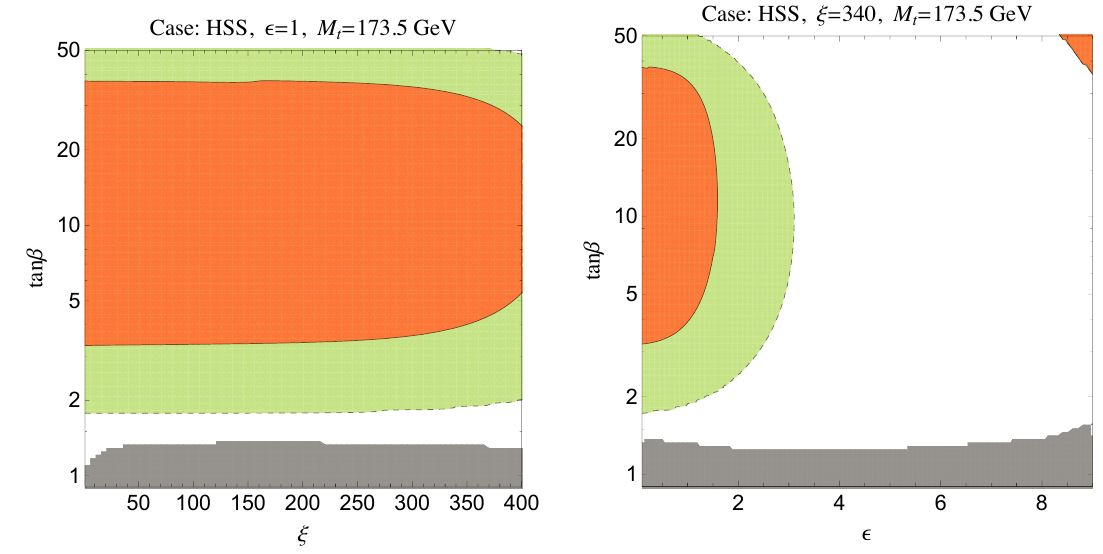
Figure 3 . The allowed values of tan (cid:12) by an absolute stability (unshaded) and metastability (green) of the scalar potential as function of (cid:24) (in the left panel) and (cid:15) (in the right panel) parameters as de(cid:12)ned in eq. (2.9) with N = 2 : 07. The orange region corresponds to unstable scalar potential while the grey region in the bottom is where the perturbativity of the couplings is